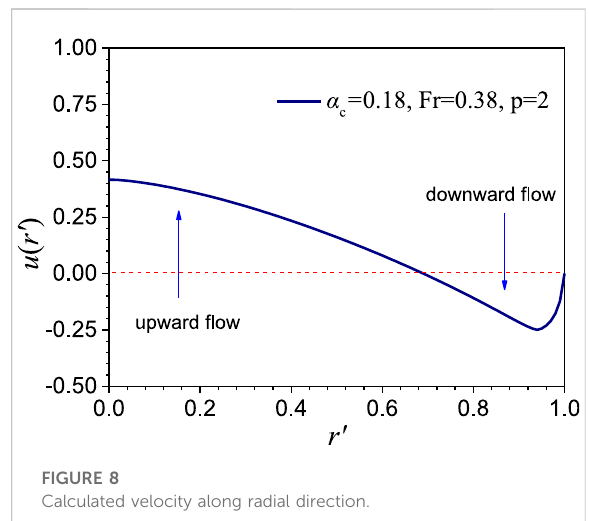
FIGURE 7 Calculation fl ow chart of Clark ’ s theoretical model.